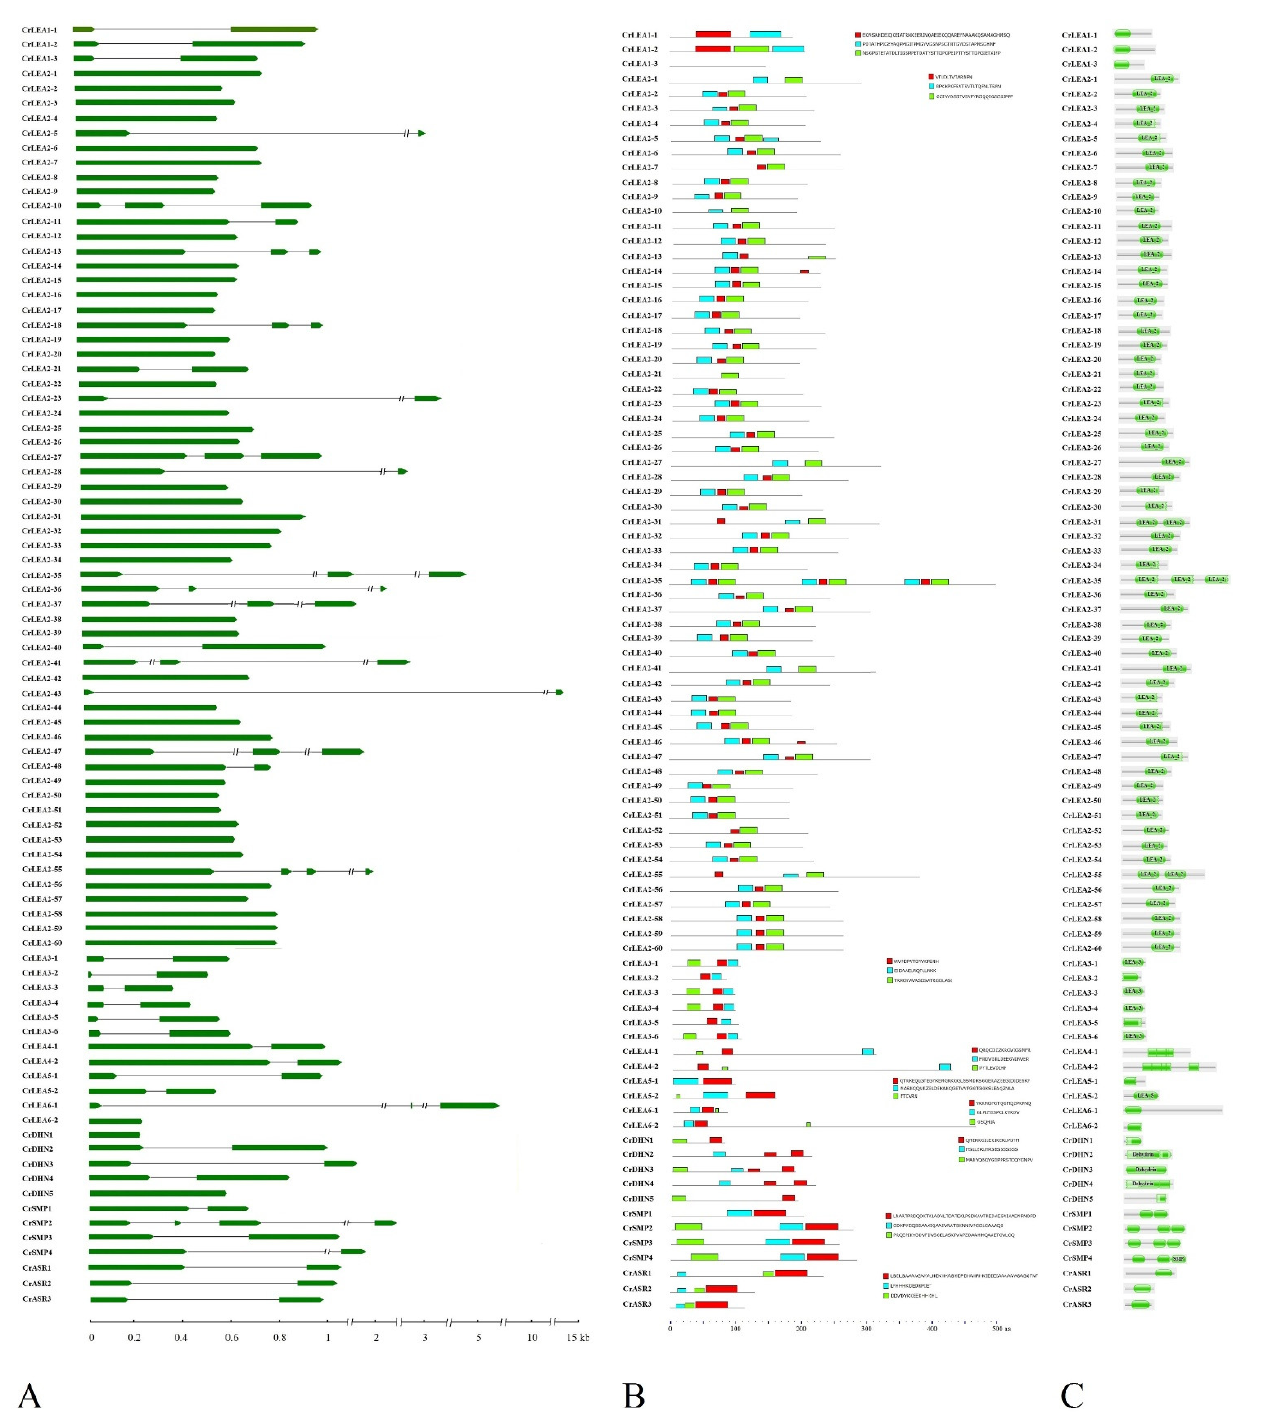
Figure 2. Exon–intron structures of CrLEA/CrASR genes and conserved motifs in CrLEA/CrASR proteins. ( A ) The lengths and positions of introns and exons were shown with black lines and thick green arrows for total of CrLEA/CrASR genes ordered by their names. ( B ) Conserved motifs of C. rosea CrLEA/CrASR proteins in the same subfamily, and these motifs were identified using Multiple EM for Motif Elicitation (MEME) and boxes with different colors represent different motifs. ( C ) Predications of CrLEA/CrASR proteins by the Pfam database (http://pfam.xfam.org/, accessed on 1 March 2021). The conserved pfam domains were marked with green